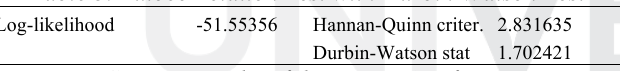
Table 3. Autocorrelation Test with Durbin-Watson